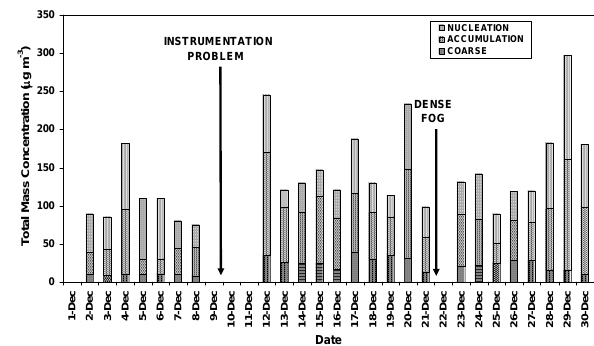
Figure 4 Fig. 4. Average aerosol mass concentration obtained during the campaign period. The total mass values are averaged for nucleation (particles radii < 0.1 µ m), accumulation (0.1–1.0 µ m) and coarse ( > 1.0 µ m) modes. Observations were made only for RH < 75%. No measurements were made during dense fog condition.